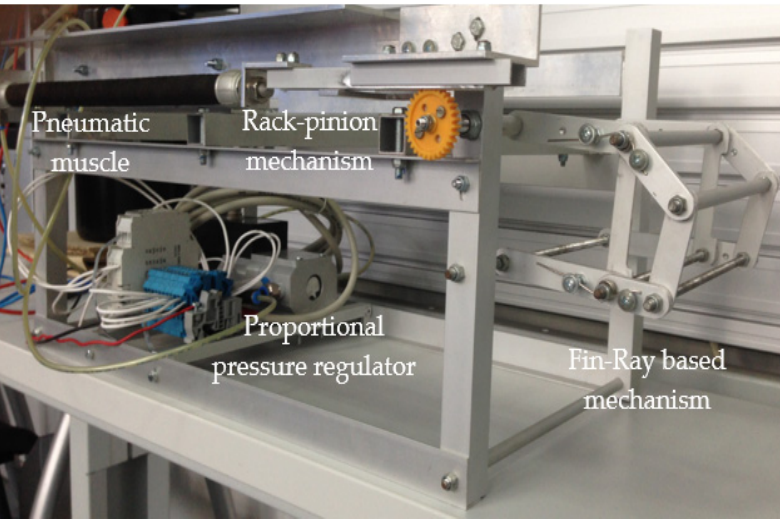
Figure 9. Pneumatic muscle actuated wrist rehabilitation equipment. Table 8. Comparison of the energy-to-mass ratios computed for the two types of